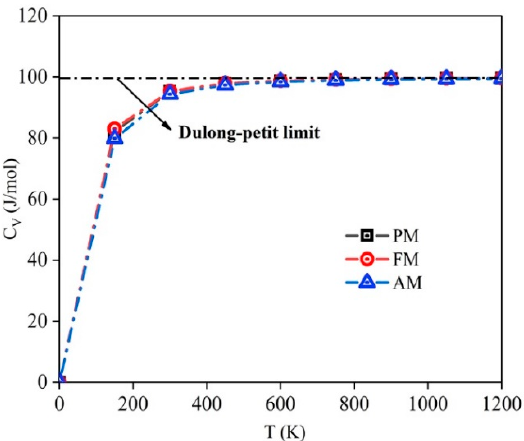
Figure 2. The isochoric heat capacity (C v ) of PM, FM and AFM phases for L1 2 -(Ni,Cu) 3